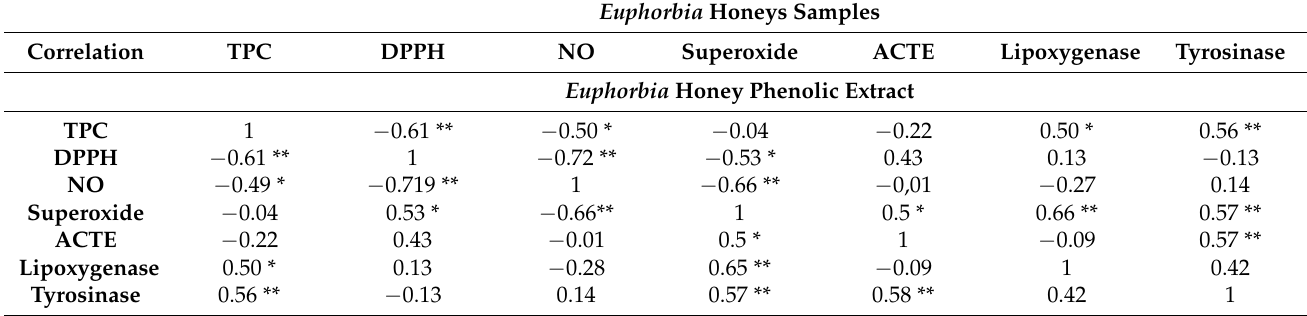
Table 9. Cont. Euphorbia Honeys Samples